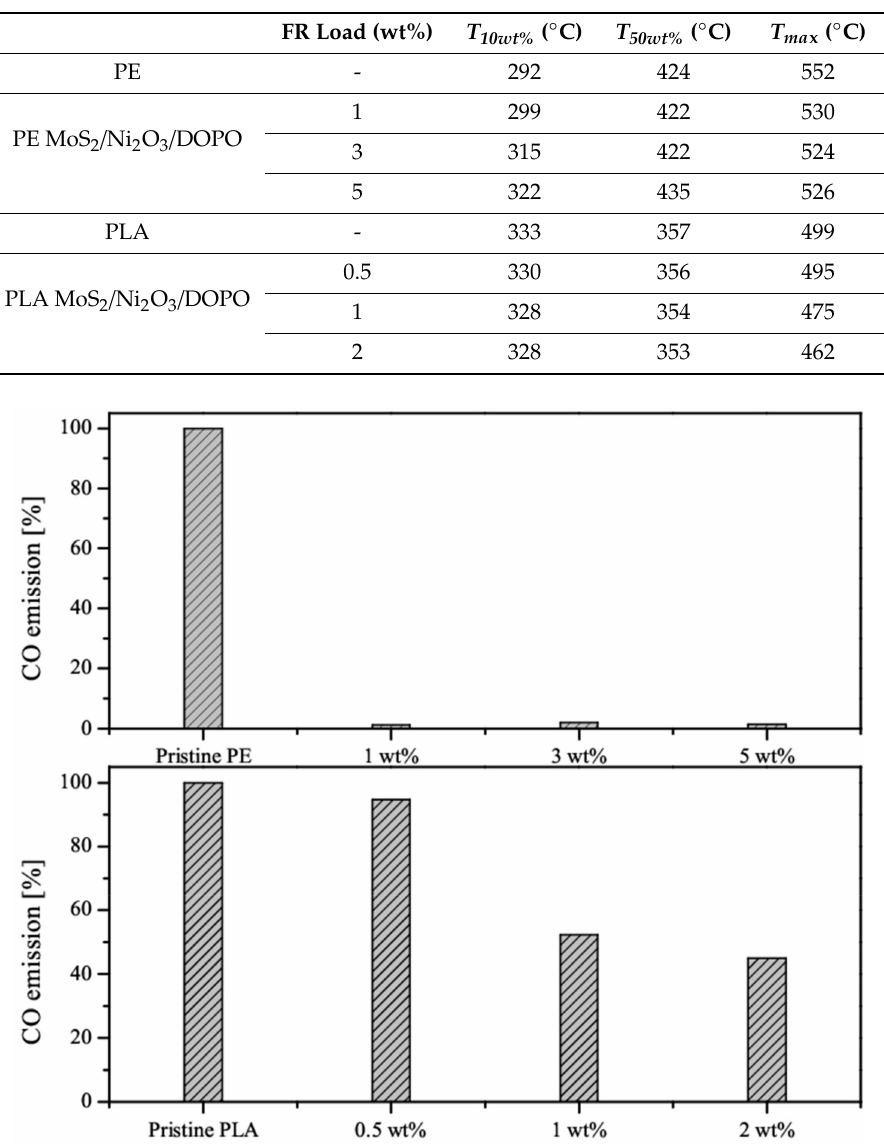
Table 1. Summary of thermogravimetric analysis (TGA) results for polyethylene (PE) and poly(lactic acid) (PLA) composites, compared to pristine polymers.